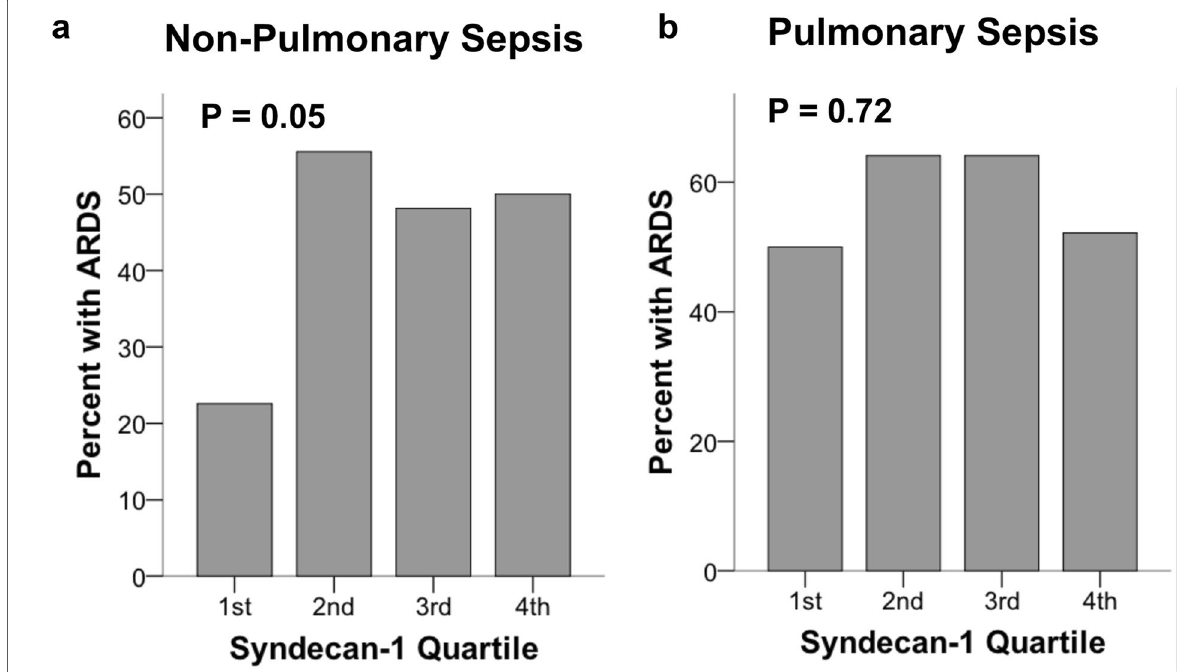
Fig. 1 Higher plasma syndecan-1 levels by quartile were associated with development of ARDS in patients with non-pulmonary sepsis ( a ) but were not associated with ARDS in patients with pulmonary sepsis ( b ). ARDS was compared across quartiles by linear-by-linear association